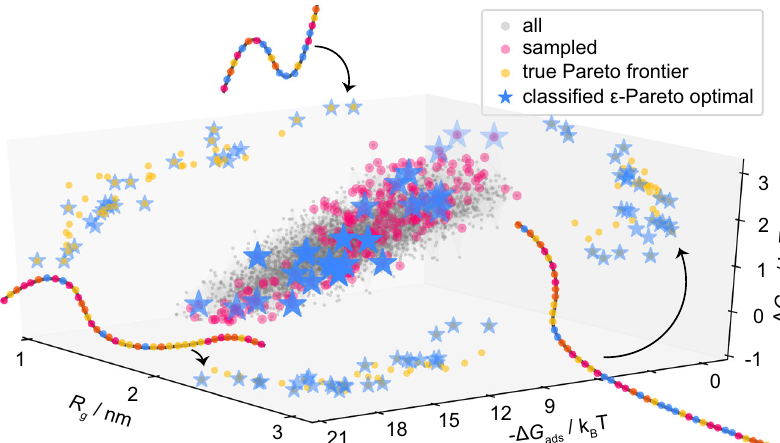
Fig. 5 Representation of polymers in property space. Simulations have been performed on the entire experimental design, to determine the three key performance indicators: the adsorption free energy ( Δ G ads ), the dimer free energy barrier ( Δ G rep ), and the radius of gyration ( R g ). Each gray point corresponds to the performance of a unique polymer. Points that have been sampled or classi fi ed as ϵ -Pareto optimal by the ϵ -PAL algorithm are marked in magenta and blue, respectively. Pareto-optimal points have also been projected on their respective 2D planes. The schematic drawings of the polymers indicate that the Pareto-optimal materials in our design space have vastly different compositions, e.g., showing a large difference in the degree of polymerization (see Supplementary Note 8).